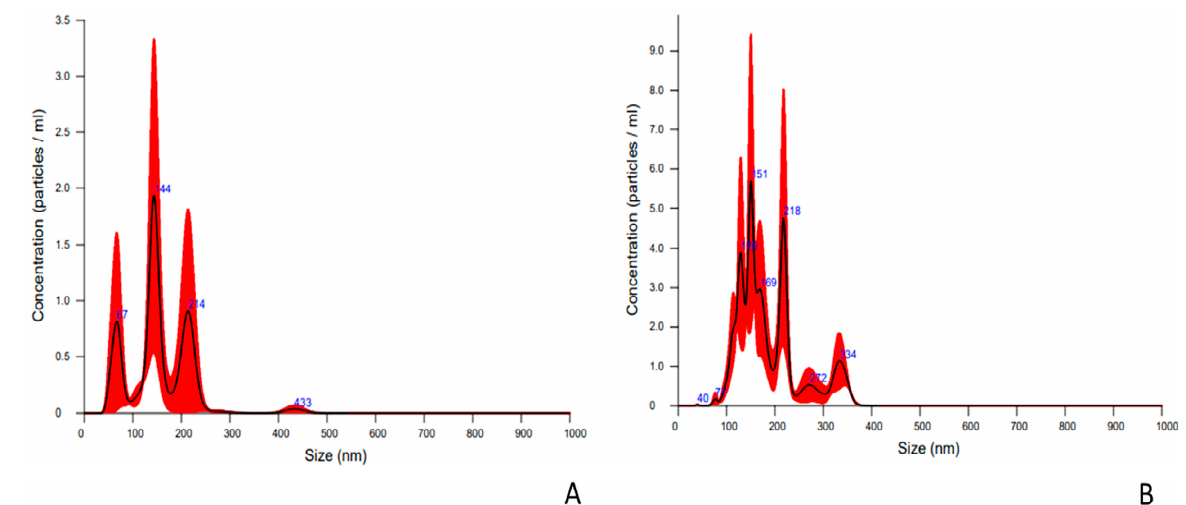
Figure 1. Size distribution (X-axis) and concentration (Y-axis; (10 9 particles × mL)) of EVs released by bovine embryos produced in vitro ( A ) or in vivo ( B ) during blastulation (morula-blastocyst). The graphics represent the average of three technical replicates, based on the diameter and concentration distribution of nanoparticles. Table 1. Size and concentration of EV populations secreted during blastulation by bovine embryos produced in vitro or in vivo.